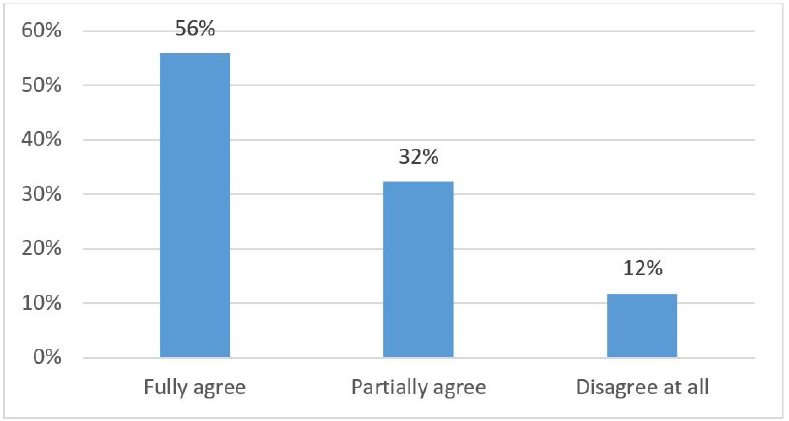
Figure 12. Respondents’ compliance with automated electronic radio log.